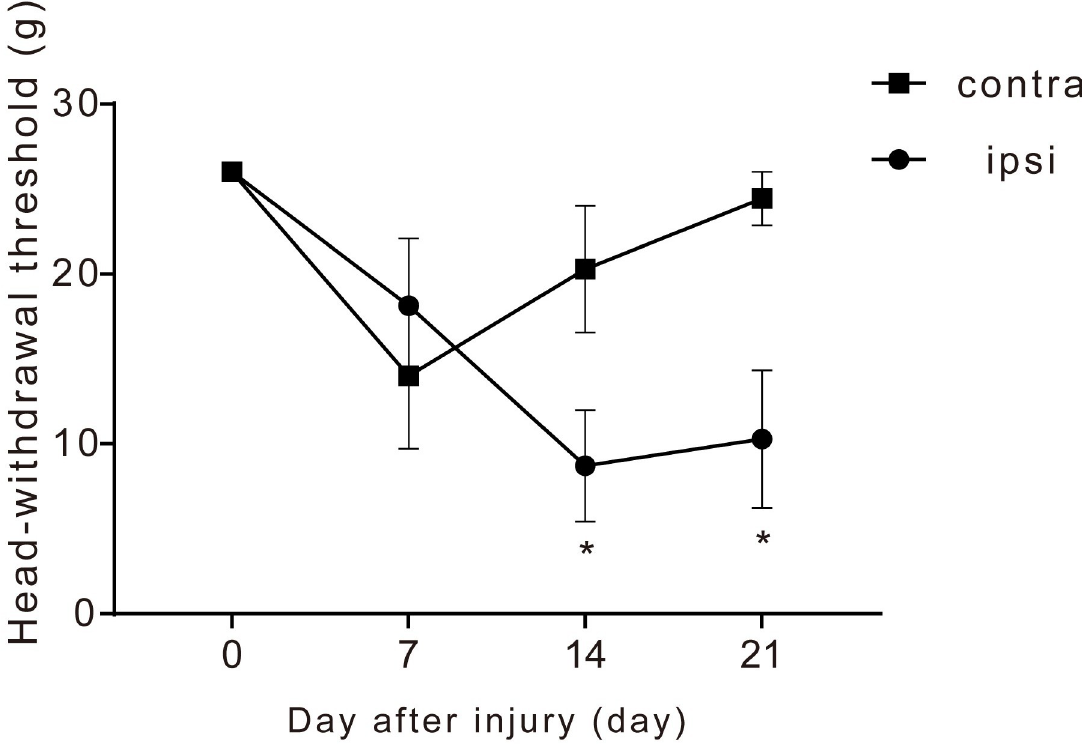
Fig 1. Time course of the development of hyperalgesia after chronic constriction injury (CCI) of infraorbital nerve (ION). Head- withdrawal thresholds after CCI-Sham injury. The ipsilateral side shows significantly decrease compared to contralateral side at 14 and 21 day after injury (n = 7). The data are presented as the mean ± SEM. � , P < 0.05; Bonferroni test (contra; contralateral, ipsi; ipsilateral). https://doi.org/10.1371/journal.pone.0251013.g001 PLOS ONE | https://doi.org/10.1371/journal.pone.0251013 April 29,